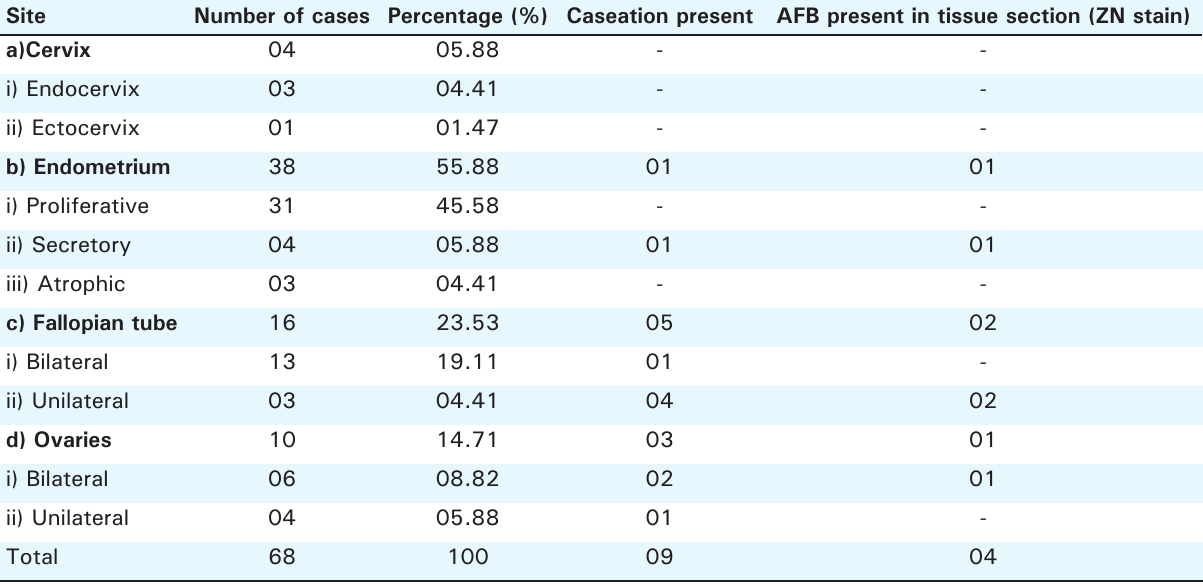
table 1. tuberculosis of different anatomical sites and percentage (n=68)